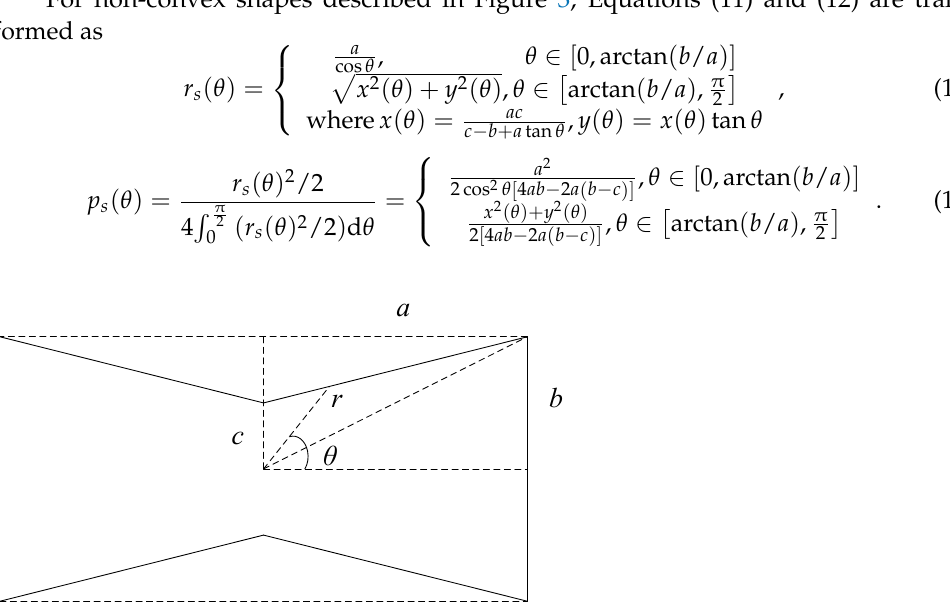
Figure 3. An illustration of the non-convex shapes transformed from a rectangle. The shape entropies of non-convex shapes from Figure 3 are calculated as Equations (13), (17) and (18). Setting b = 1, c varying from 0.1 to 1 and a = 1, 1.5, 3 , and 2, the shape entropies are shown in Figure 4. The results show that non-convex shapes are more irregular as c decreases, which is intuitive. Therefore, it is reasonable to compare the difference between the two-dimensional shape and the circle with the shape entropy defined by Equations (2)–(4).